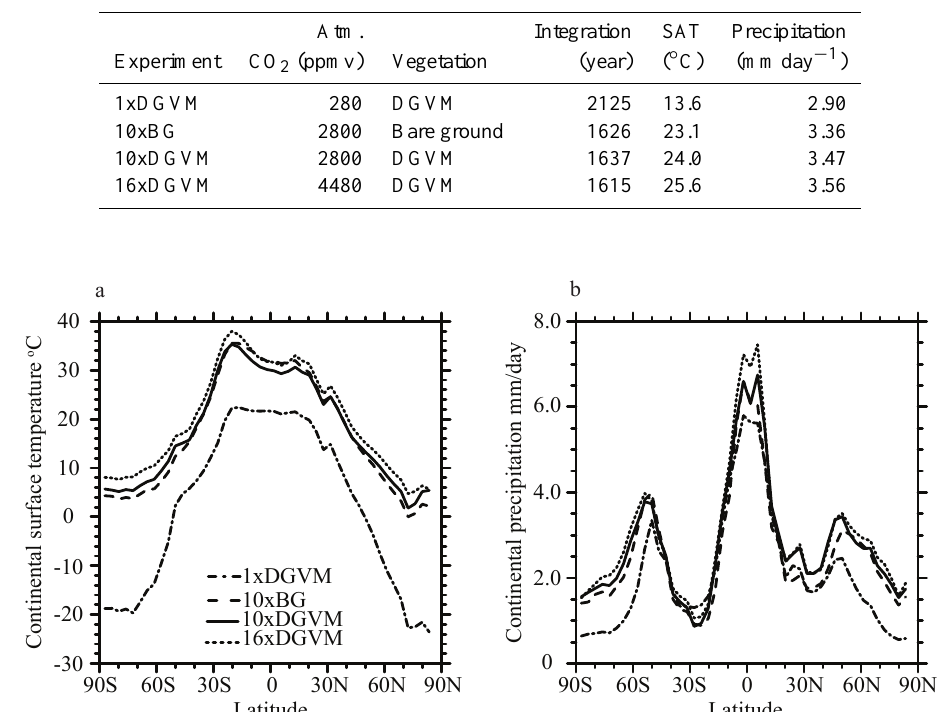
Fig. 1. Zonal-average annual mean continental surface temperature ( ◦ C) (a) ; and precipitation (mm day − 1 ) (b) for the 1xDGVM (black dash-dot line), 10xBG (black dashed line), 10xDGVM (black solid line) and 16xDGVM (black dotted line) experiments, respectively.